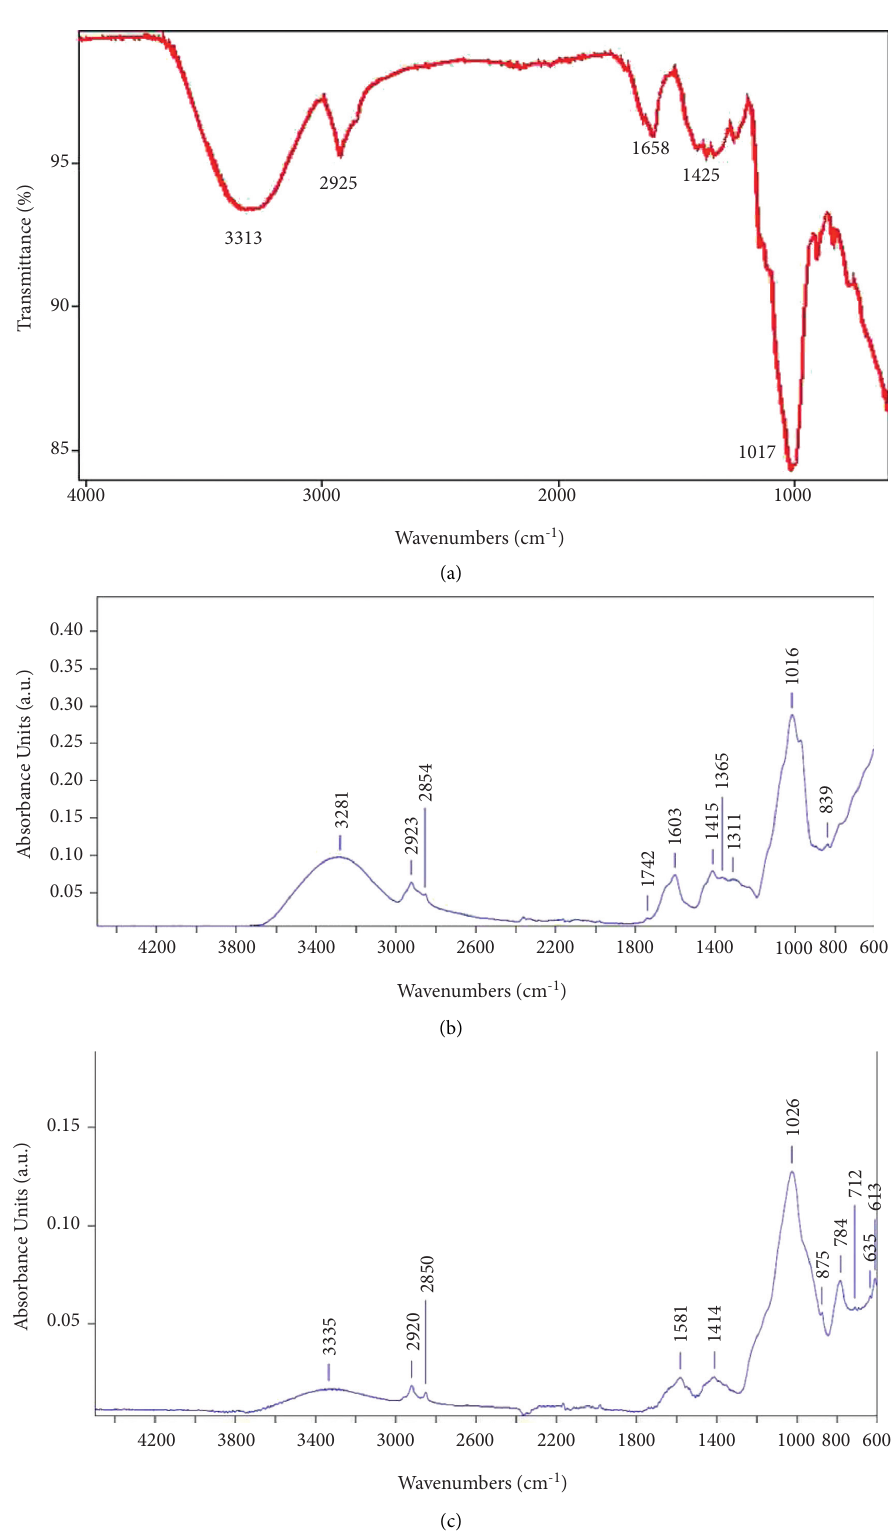
Figure 13: The infrared analysis of gum Arabic sample; the adhesive substance on the back side for blue stamp (a) and red stamp